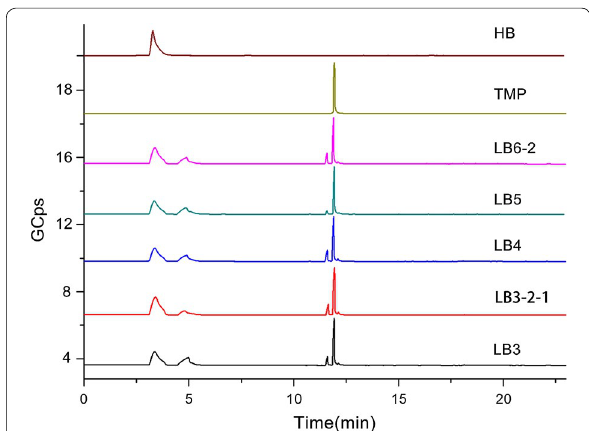
Fig. 5 Total ion current chromatogram of five strains of endophytic bacteria isolated from RC. The spectra of samples matched well with authentic compounds of HB and TMP, 2,3-BD and 1,1-DAH were identified from MS data library. The retention time was 3.888 min for HB, 4.888 min for 2,3-BD, 11.608 min for 1,1-DAH and 11.898 min for TMP